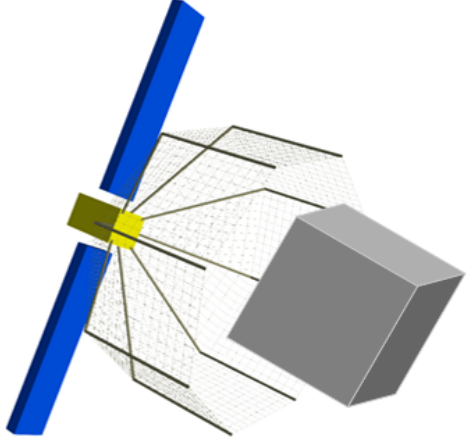
Figure 1. Space netted pocket capture mechanism.